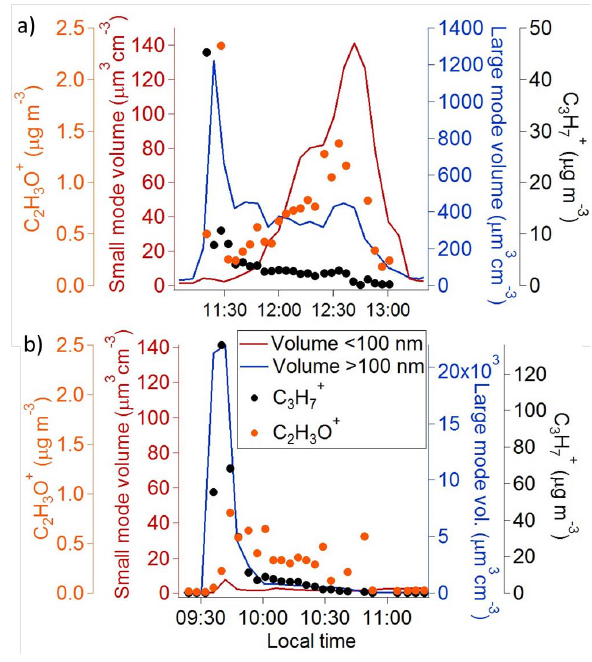
Fig. 9. Volume concentrations in the large (particle diameter >100nm) and the small (particle diameter <100nm) modes, and concentrations of C 2 H 3 O + and C 3 H + on 17 July (a) and 18 July 7 (b) . The large-mode volume concentration decreases with plume age on both days. On 17 July, the volume concentration in the small mode increases as the plume ages, while on 18 July, no such dra- matic increase is observed. C 2 H 3 O + covaries with the small parti- cle mode on 17 July, while C 3 H + covaries with the large particle 7 volume on both